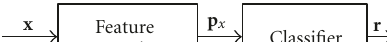
v = [ v ( n ) ··· v ( n − N + 1)] T is constituted by samples of the additive noise.